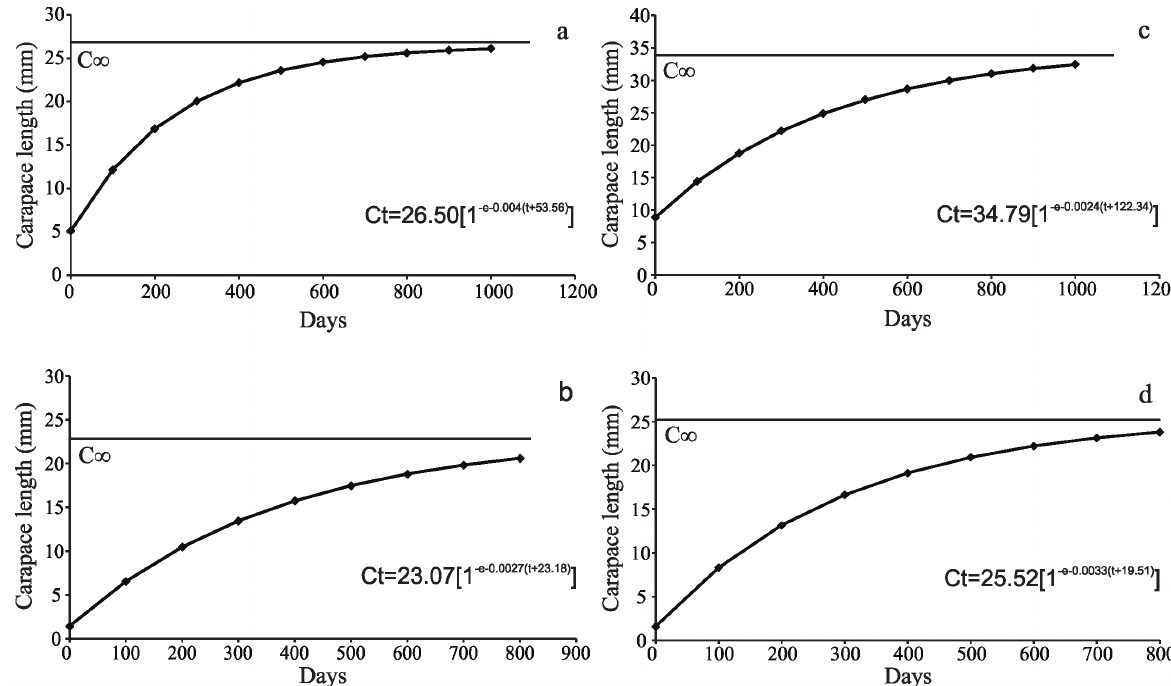
Figure 5. Aegla schmitti in the Arraial River (a and b) and Capivari River (c and d). Growth curves for males (a and c) and females (b and d) based on the von Bertalanffy (1938) model. (Ct) carapace length in a given t time; (Cα) mean maximum carapace length (mm); (t) age, in